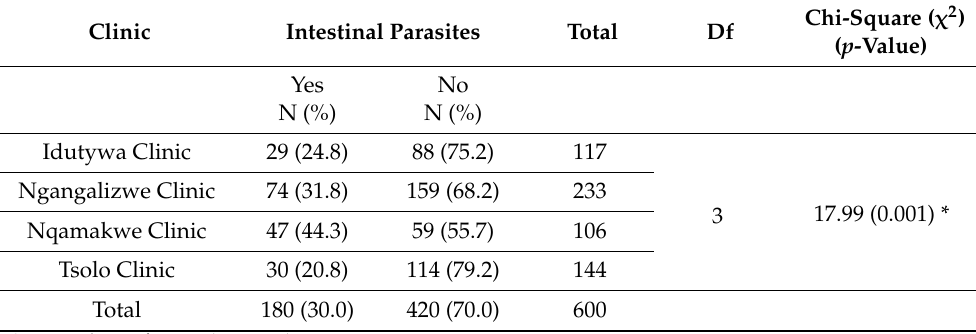
Table 2. Prevalence of intestinal parasites by site (clinic).